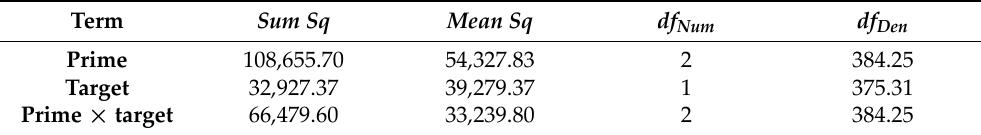
Table 1. Fixed‑effect ANOVA results for